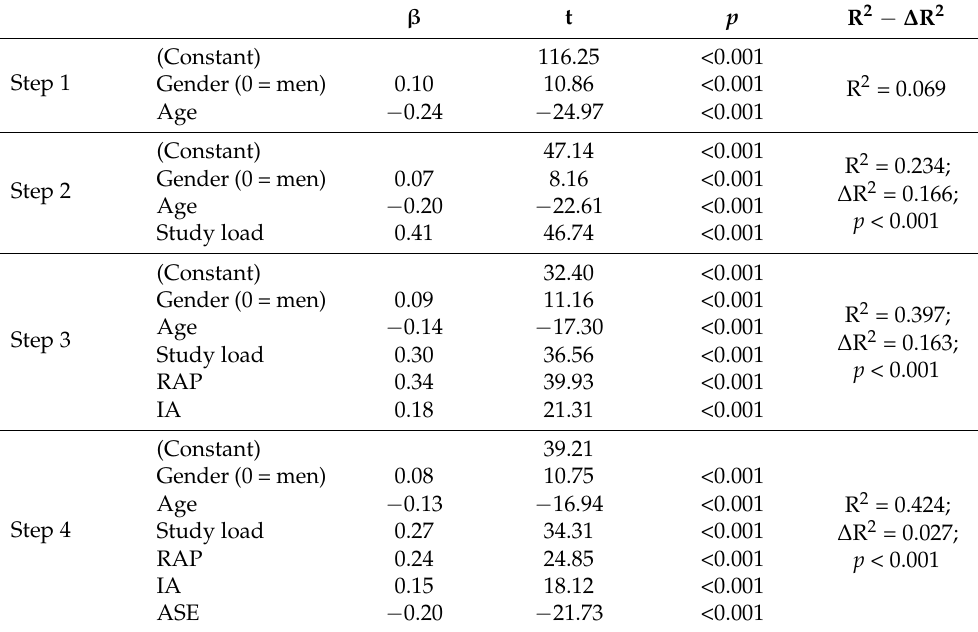
Table 6. Hierarchical multiple regression with exhaustion as dependent variable (N =